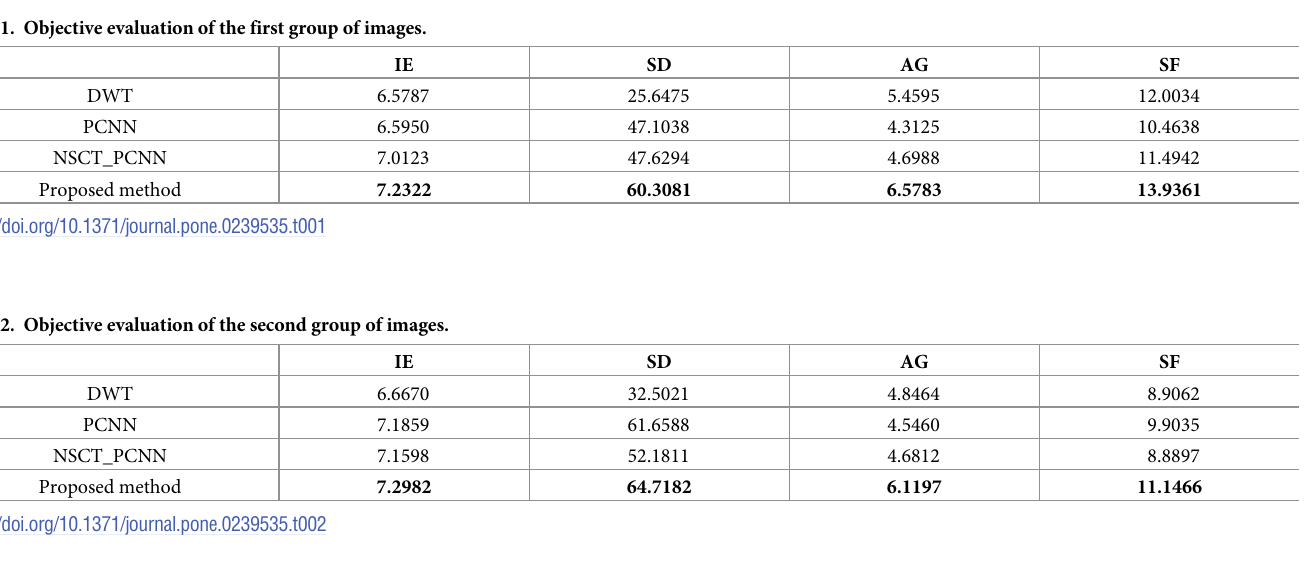
Table 1. Objective evaluation of the first group of images.